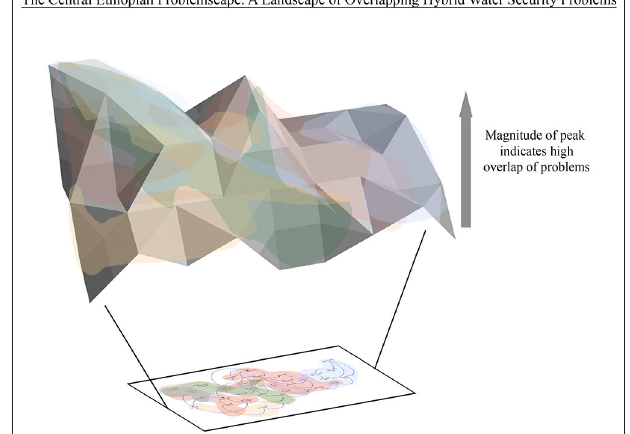
FIGURE 8 | The CEC problemscape